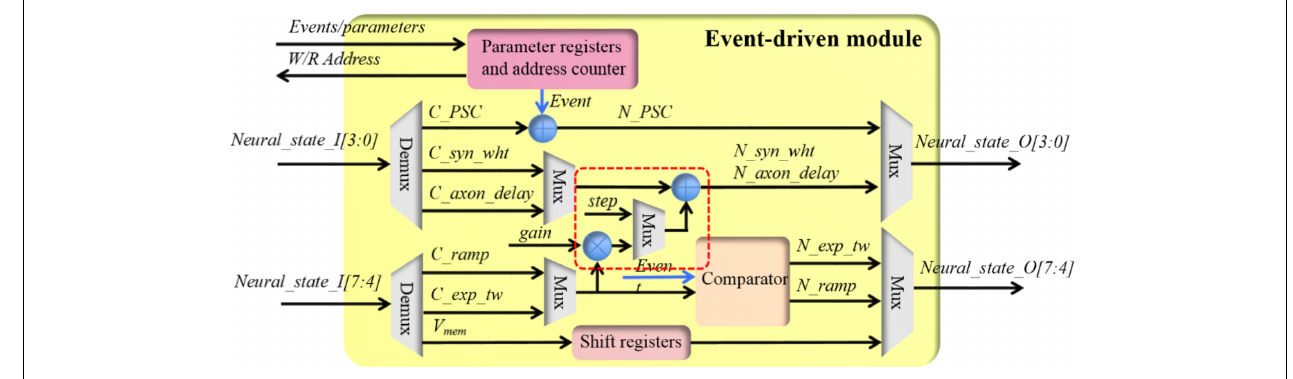
FIGURE 6 | The structure of the event-driven